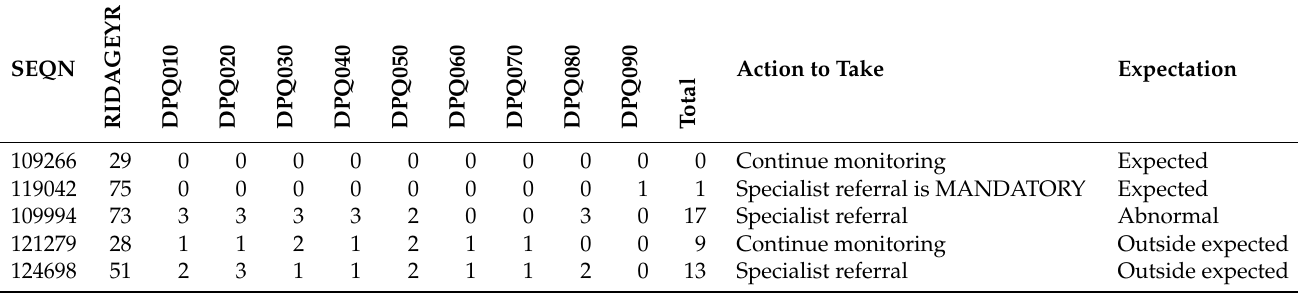
Table 9. Exemplification of the results, including the LabVIEW decision system. The complete table is reported in [64].